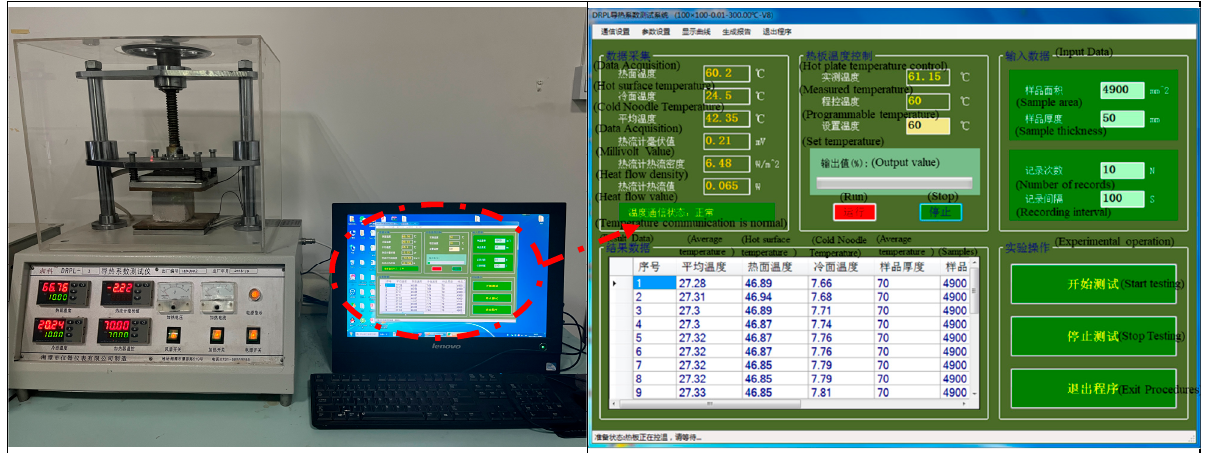
Figure 3. Measurement of the thermal conductivity of the specimen. Left subfigure: DRPL-I thermal conductivity tester; right subfigure: DRPL test system.